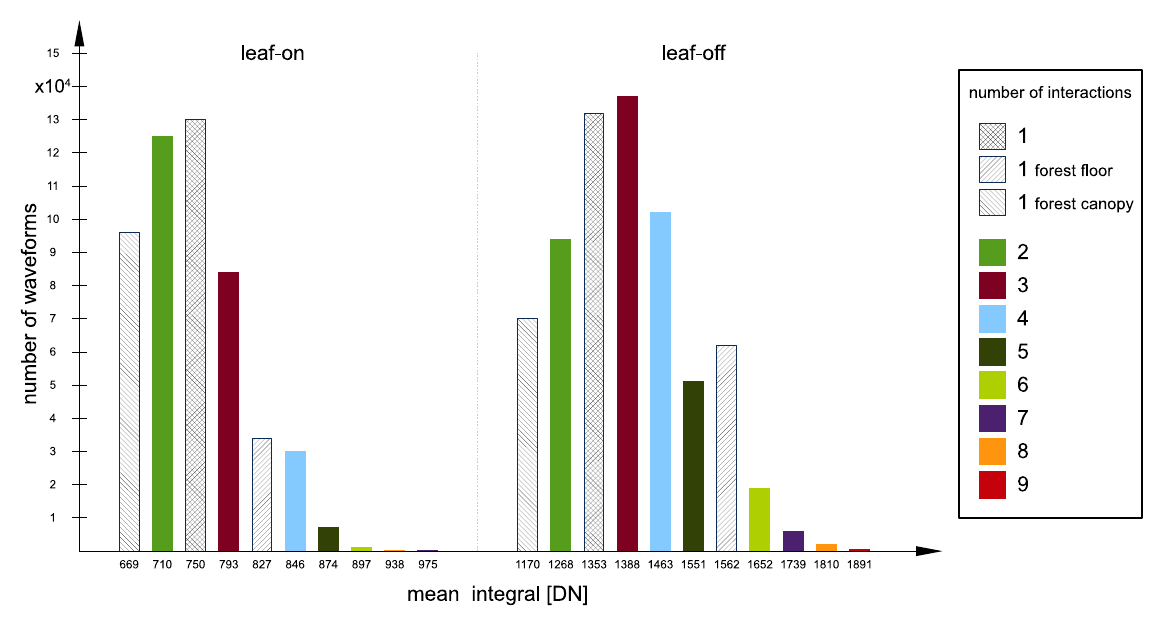
Figure 8: Summary of the evaluation of all waveforms in the test regions